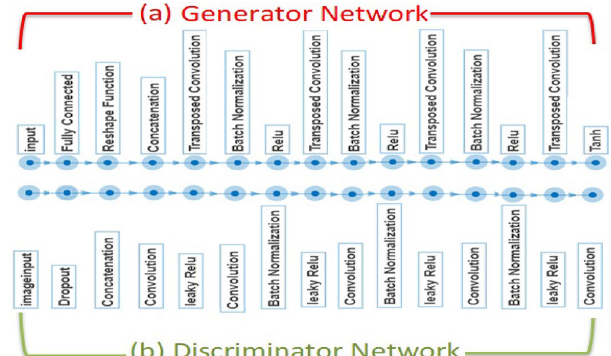
Figure 7. The total structure of G and D networks included in the introduced CGAN